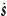
s˙ of SFS-SOSM control.